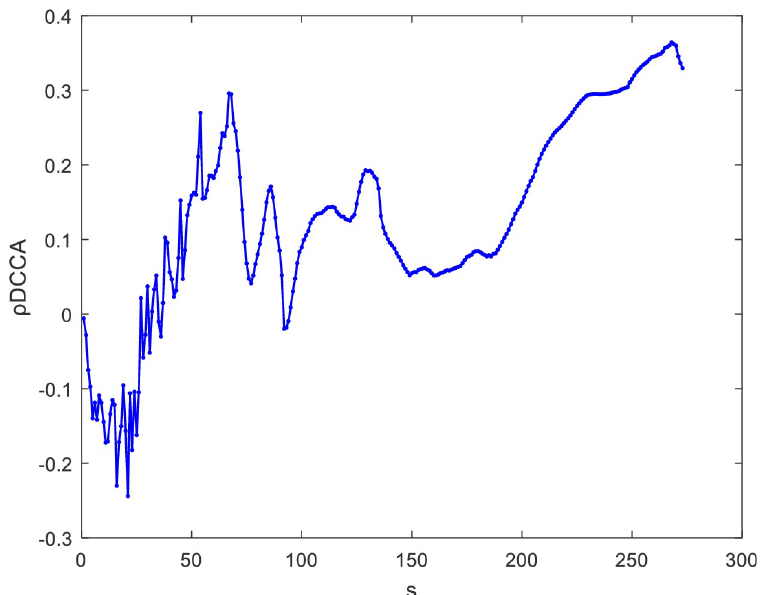
Fig 3. The DCCA coefficient between SHIBOR and